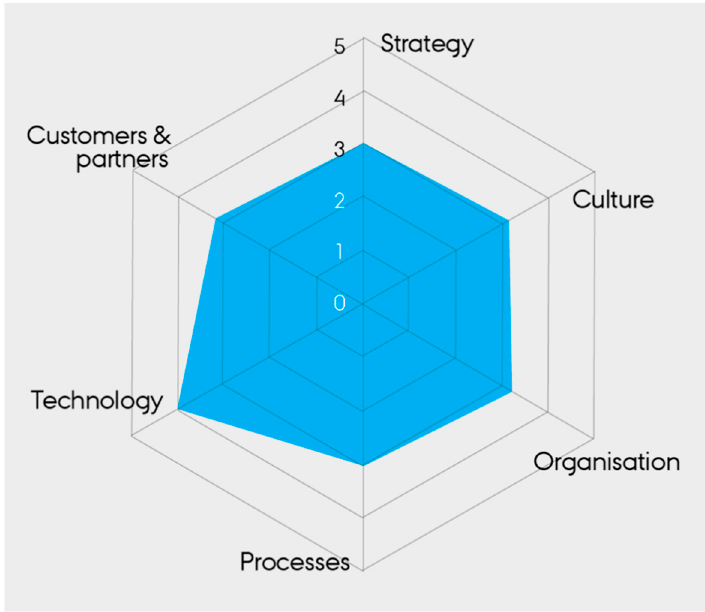
Figure 1. Spider web diagram results using the DMAT assessment tool.